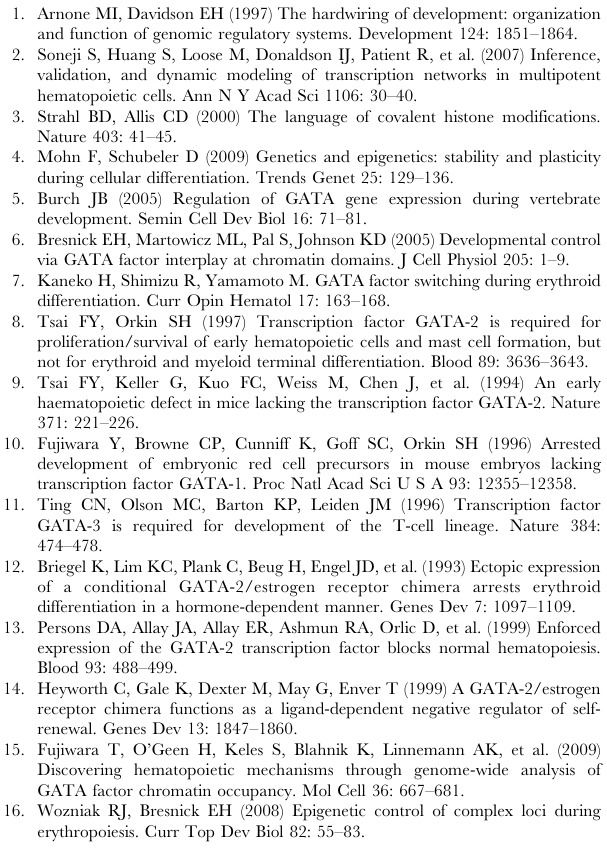
Figure S1 D -1.8 targeting construct generation. Graphical representation of the generation of the targeting construct to replace the palindromic GATA-binding site 2 1.8 kb upstream of the 1S transcriptional start site with a loxP-flanked PGK-neomycin cassette (A). Southern blot strategy outlining the HindIII/SalI digested fragment sizes for the wild-type and targeted alleles, and probe hybridization sites (B). Southern blot of D -1.8 germline mice